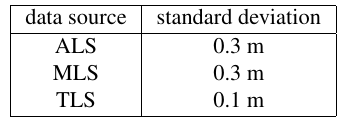
Table 1. Standard deviation of the utilized data sources.